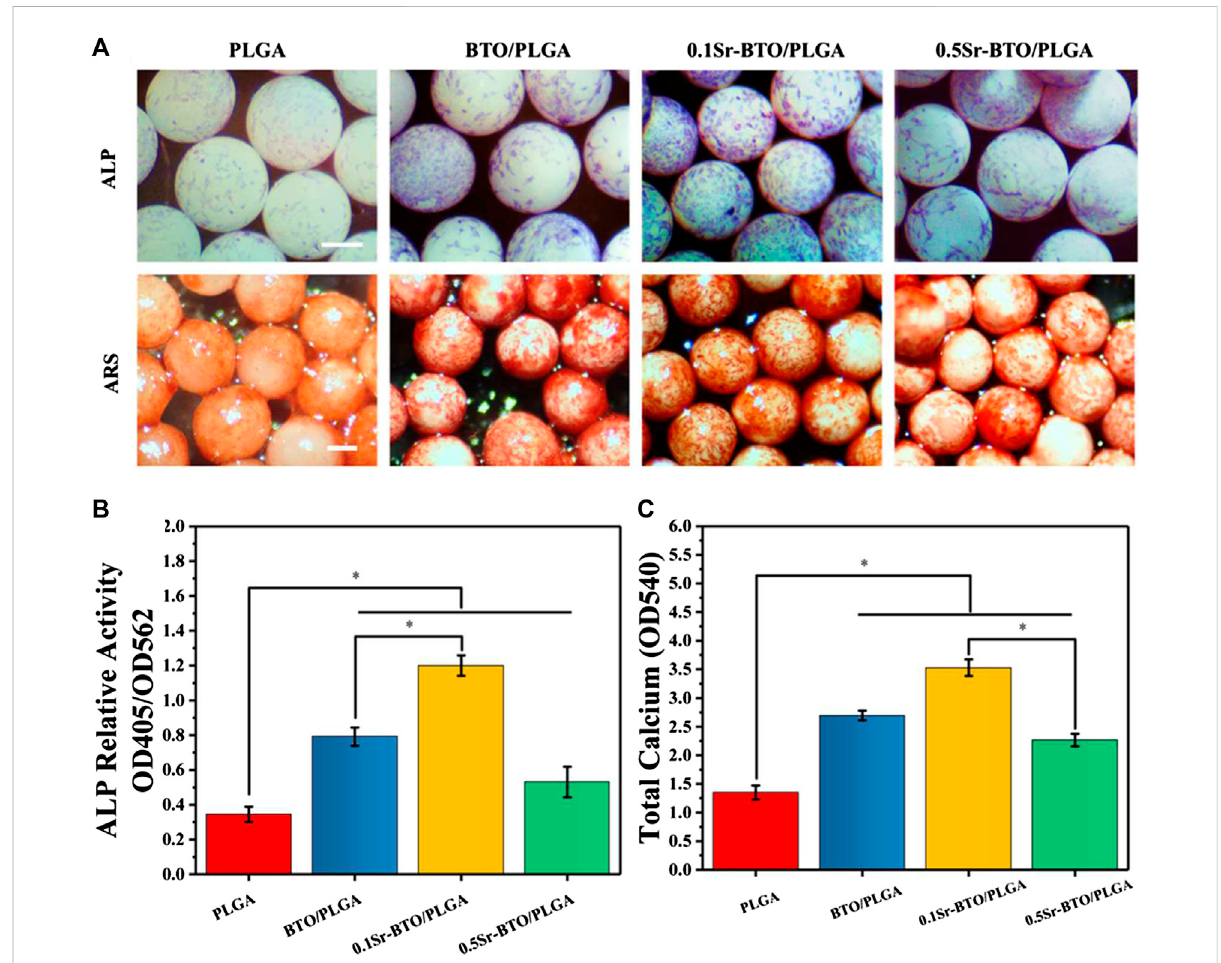
FIGURE 5 (A) The ALP and theAlizarin Red staining ofMC3T3-E1 cells cultured on microspheres. Scale bar:200 μ m (B) The quantitative evaluation ofALP relative activity of MC3T3-E1 cells cultured on microspheres for 7 days (C) The Alizarin Red staining quantitative evaluation of calcium